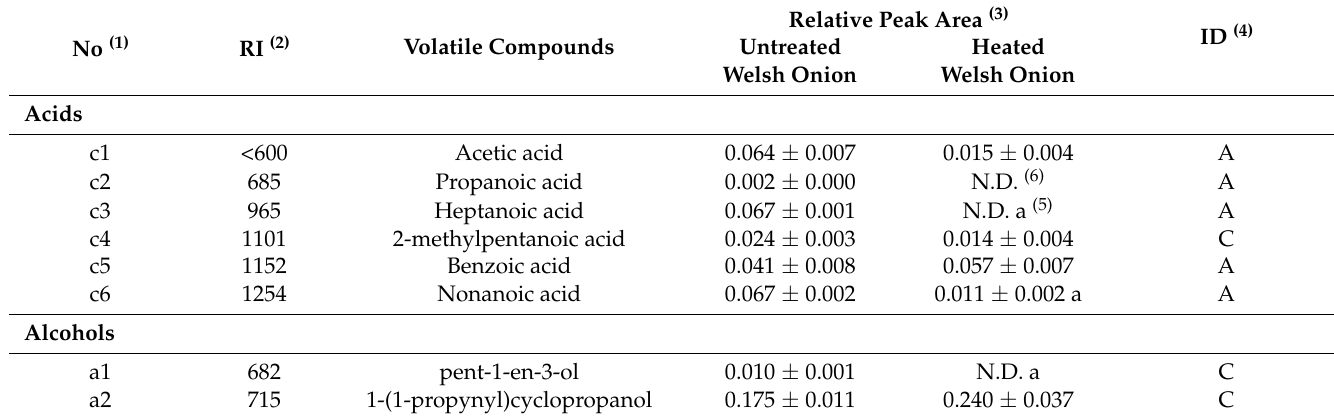
Table 1. Volatile compounds identified in the untreated and heated Welsh onion